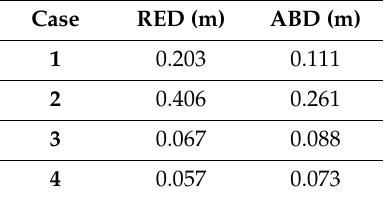
Table 1. Summation of RED and